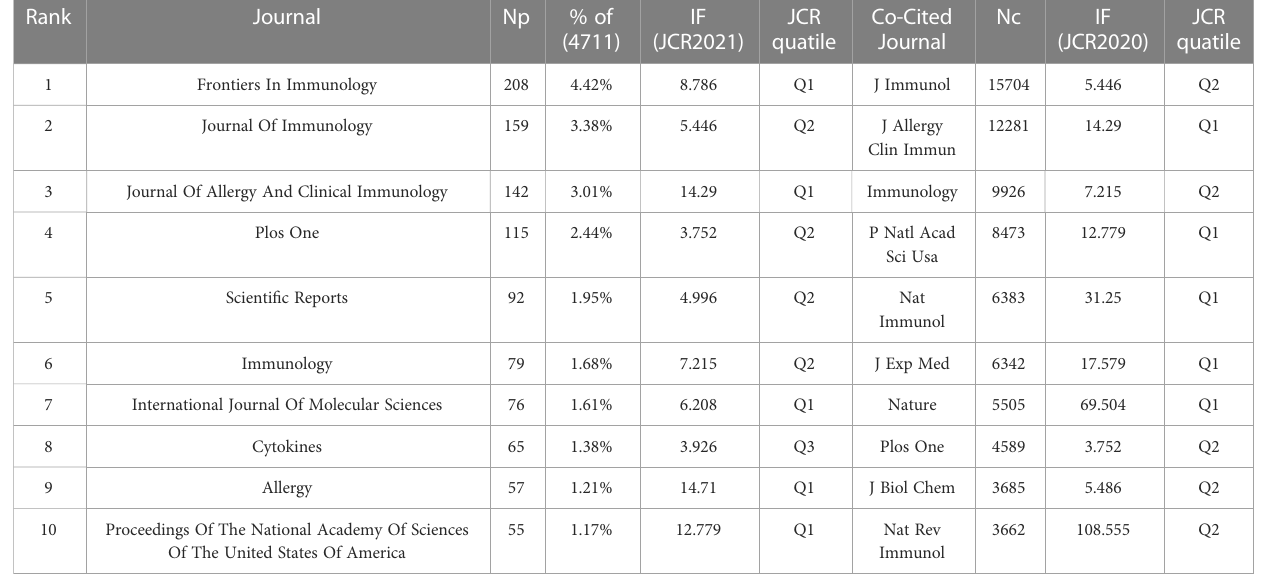
TABLE 3 The top 10 productive academic journals with publications concerning